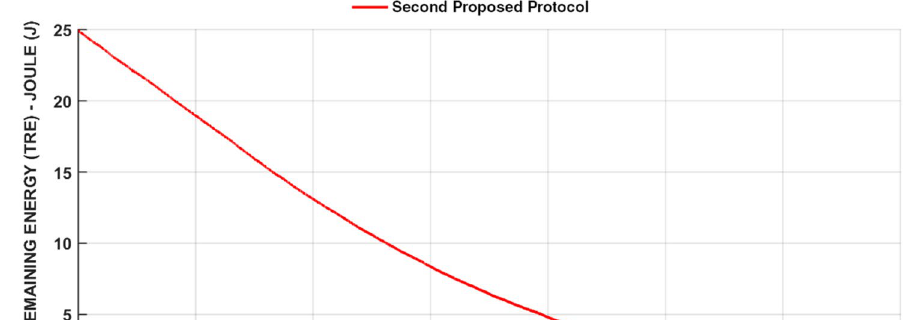
Fig. 8 Total remaining energy in relation to the number